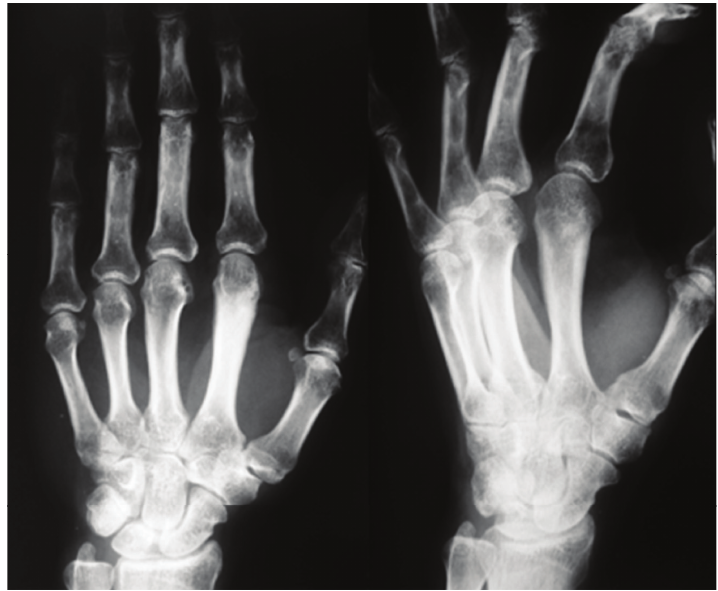
Figure 18: Two-year postoperative radiological presentation without tumor